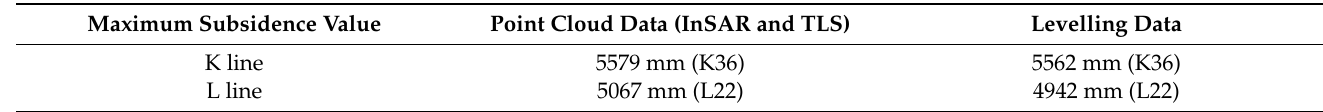
Table 7. Comparison of maximum subsidence values monitored by level data and fused